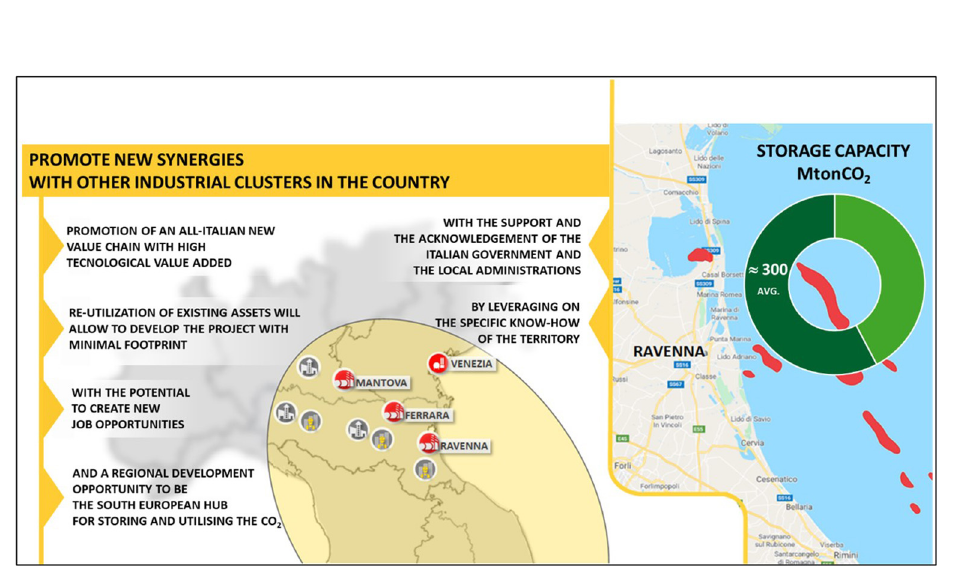
Fig. 24. – Adriatic Blue CCS project. The aim is to de-carbonize Italian industrial districts by means of CO 2 injection in offshore depleted gas reservoirs. Existing facilities (pipelines, platforms) will be